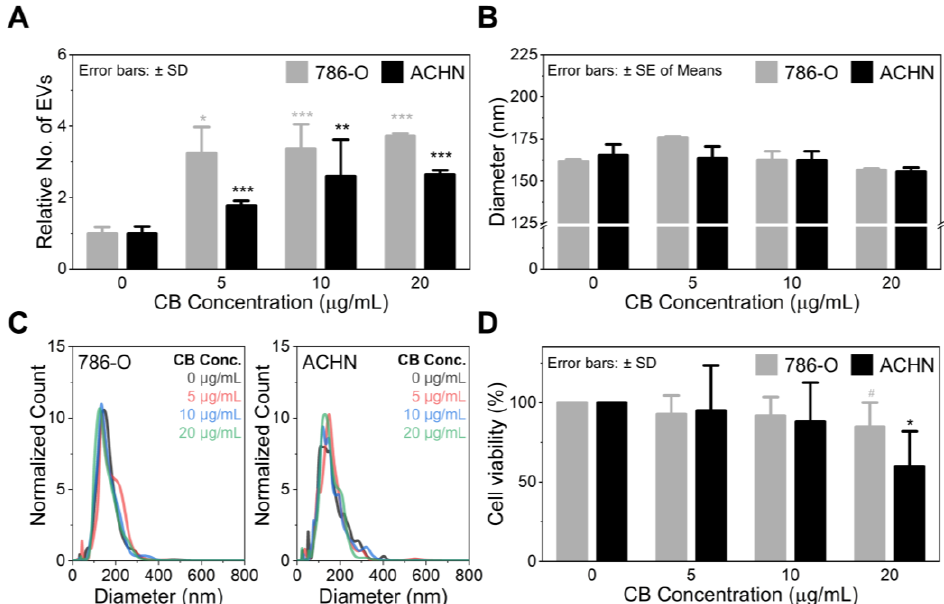
Figure 2. The effect of cytochalasin B on ( A ) EV production, ( B , C ) size distribution of the produced EVs, and ( D ) cell viability. Significance levels are indicated as # p < 0.10, * p < 0.05, ** p < 0.01, and *** p < 0.001, compared to the non-CB treated cells. NTA data were obtained from at least three independent experiments, performed in triplicates ( n ≥ 3). The cell viability was measured from three independent experiments, performed in duplicates ( n =